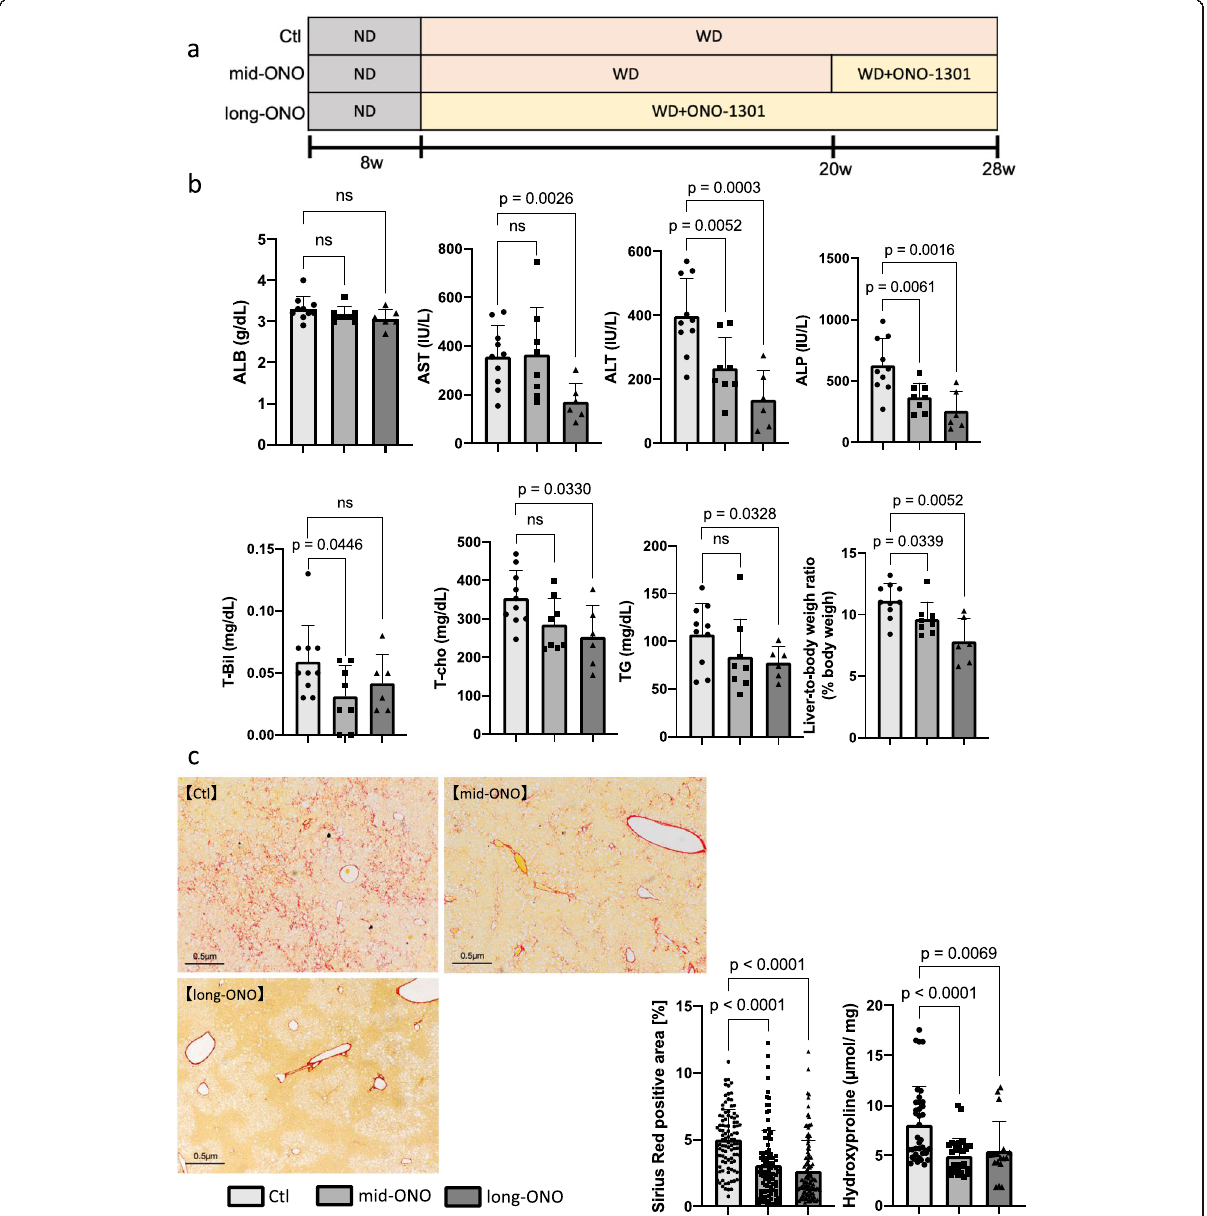
Fig. 2 Therapeutic effects of ONO-1301 (8- or 28-week treatment) in Mc4r -KO NASH model mice. Mc4r -KO mice were fed a Western diet from 8 weeks of age and followed up for an additional 28 weeks. A Schematic of the experiment. B Serum levels of albumin (ALB), aspartate transaminase (AST), alanine transaminase (ALT), alkaline phosphatase (ALP), total bilirubin (T-Bil), total cholesterol (T-cho), and triglyceride (TG). Liver-to-body weight ratios were analyzed. C Sirius Red staining and D quantification of hydroxyproline levels. Total number of mice in each group: n = 10 in Ctl group, n = 8 in mid-ONO group, n = 6 in long-ONO group. Scale bar = 500 μ m. Data are presented as mean ± standard deviation. ns: not